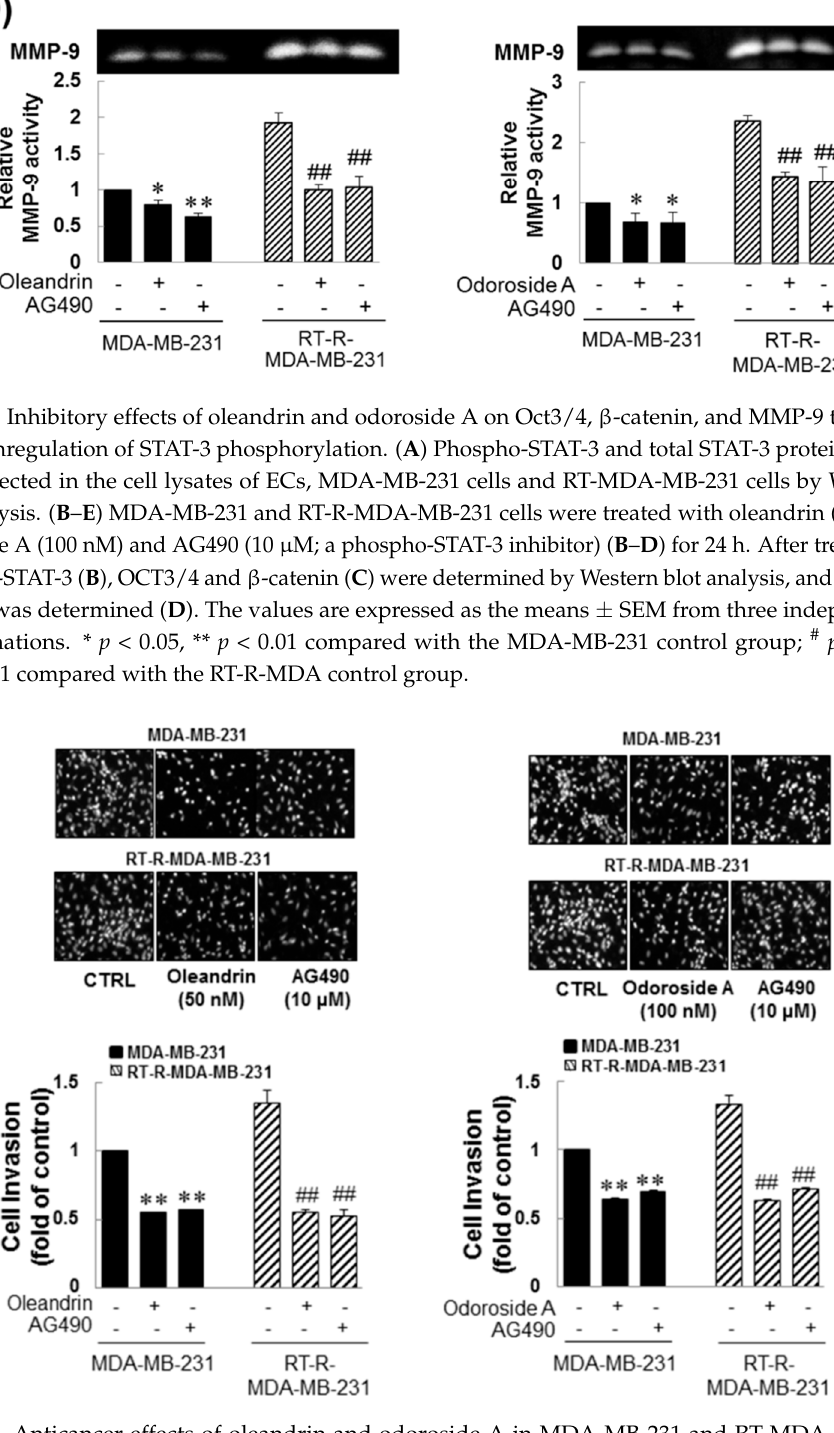
Figure 6. Anticancer effects of oleandrin and odoroside A in MDA-MB-231 and RT-MDA-MB-231 cells through the downregulation of phospho-STAT-3. MDA-MB-231 and RT-MDA-MB-231 cells were treated as described in Figure 5, and then the cells were collected and added to ECs-Matrigel-coated insert wells. The cells were incubated overnight (for 16 h) at 37 °C, and then the cells that had invaded across the membrane were stained with DAPI and counted as described in Figure 3 (×200 field image). The values are expressed as the means ± SEM from three independent determinations. ** p < 0.01 compared with the MDA-MB-231 control group; ## p < 0.01 compared with the RT-R-MDA-MB-231 control group.